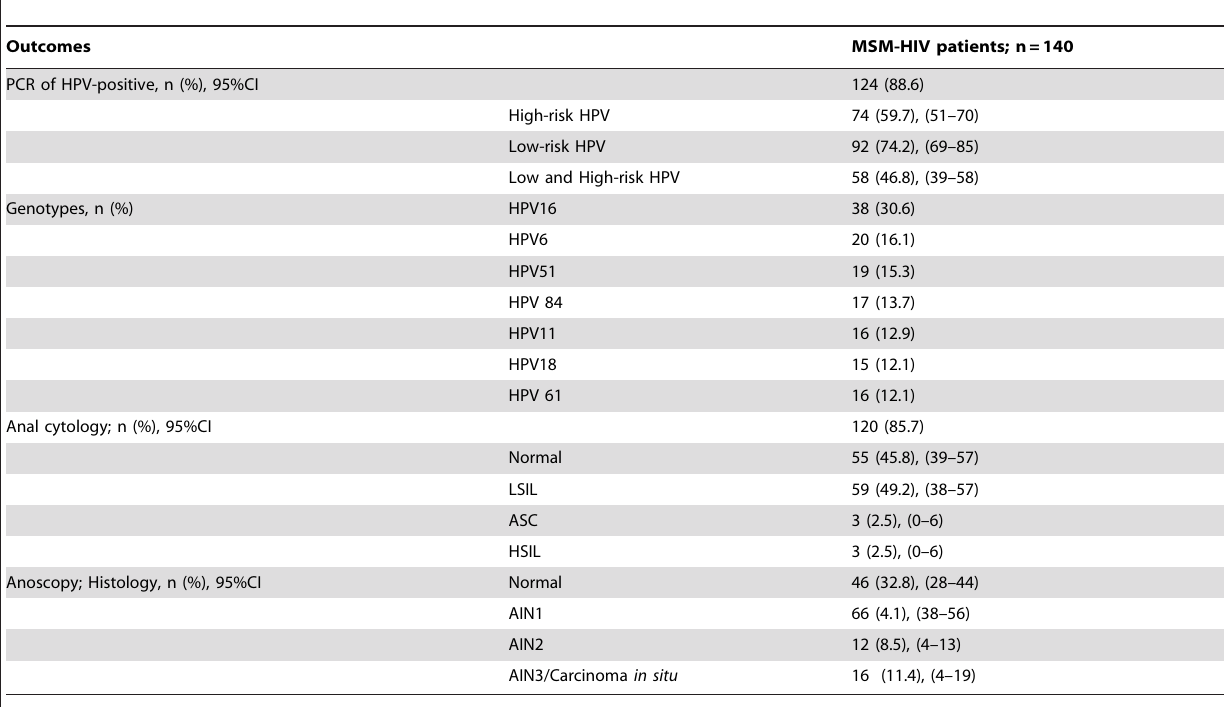
Table 2. Results of the PCR of HPV, cytology and anoscopy.